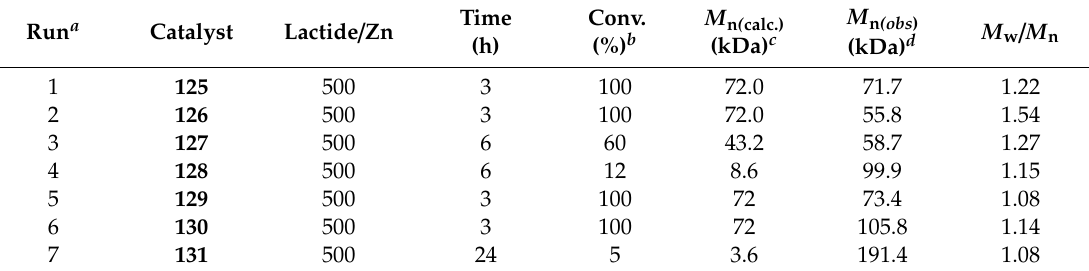
Figure 22. Zn ketoiminate complexes bearing trifluoromethyl substituents [78]. Table 7. Polymerization of L -LA catalyzed by Zn complexes 125–131 [78].